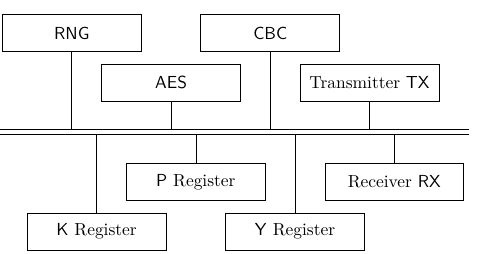
Figure 3: Functional modules of the CBC-encryption core, connected via a central data